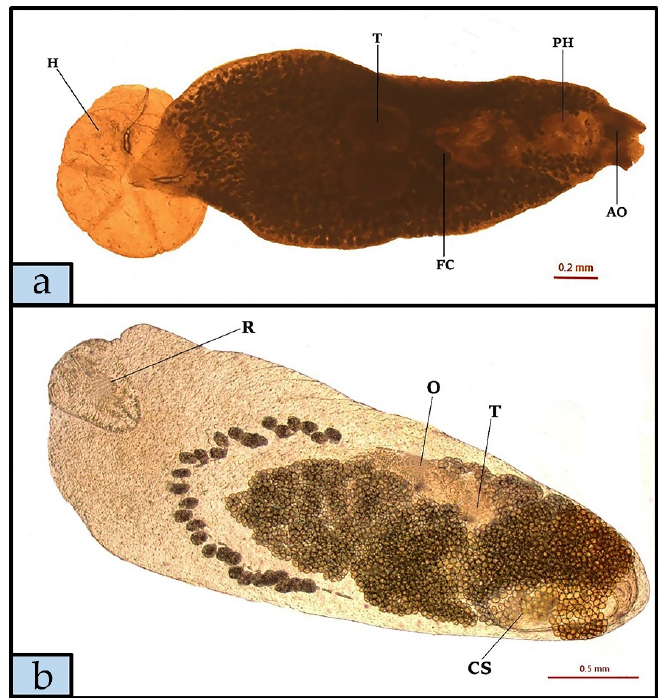
Figure 3. Megalocotyle hexacantha ( a ) specimen isolated from Epinephelus marginatus gills, glycerine diaphanization (H, Haptor; T, Testis; FC, Internal fertilization chamber; PH, Pharynx; AO, Anterior fixation organ) and Prosorhynchus caudovatus specimen ( b ) isolated from the E. marginatus stomach, glycerine diaphanization (R, Rhynchus; O, Ovary; T, Testis; CS, Cirrus sack).